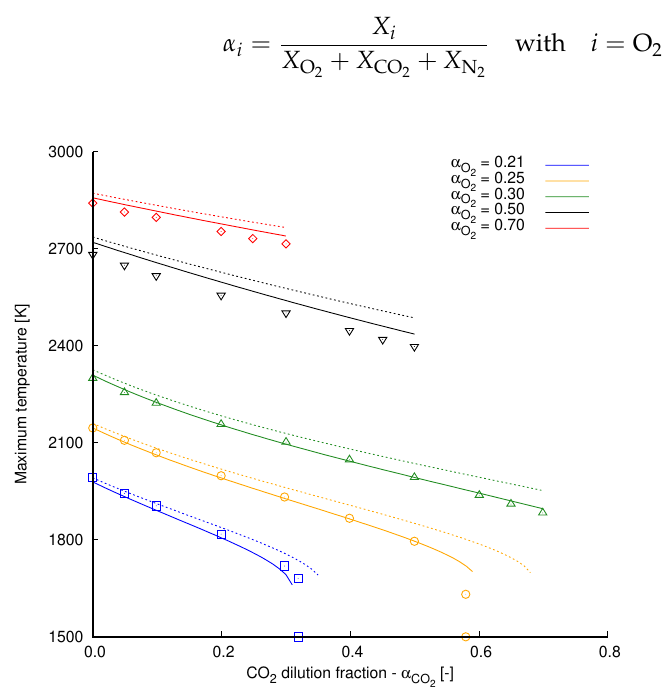
Figure A1. Maximum flame temperature by CO 2 dilution fraction at different oxidizer compositions. Results are obtained from counterflow methane flames simulated with the mechanism GRI 3.0. Continuous lines, radiation included; dashed lines, radiation neglected; marks, simulation results extracted from Park et al.